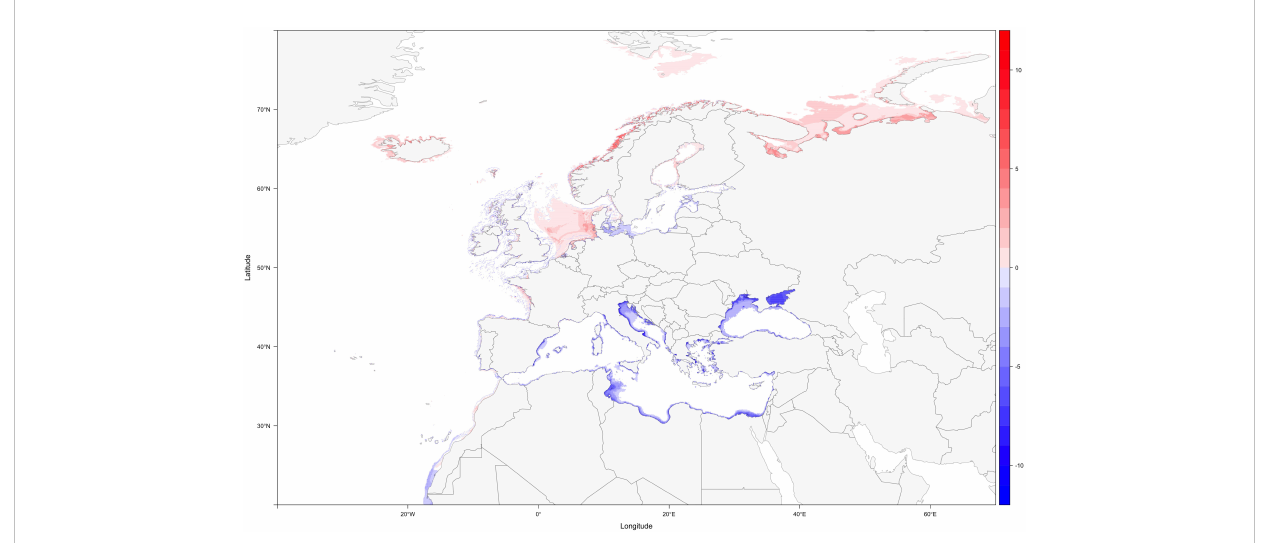
FIGURE 2 Difference in species richness from the present to the 2090-2100 time period, under RCP 8.5 (blue shows areas with loss of species, and red shows areas of increased